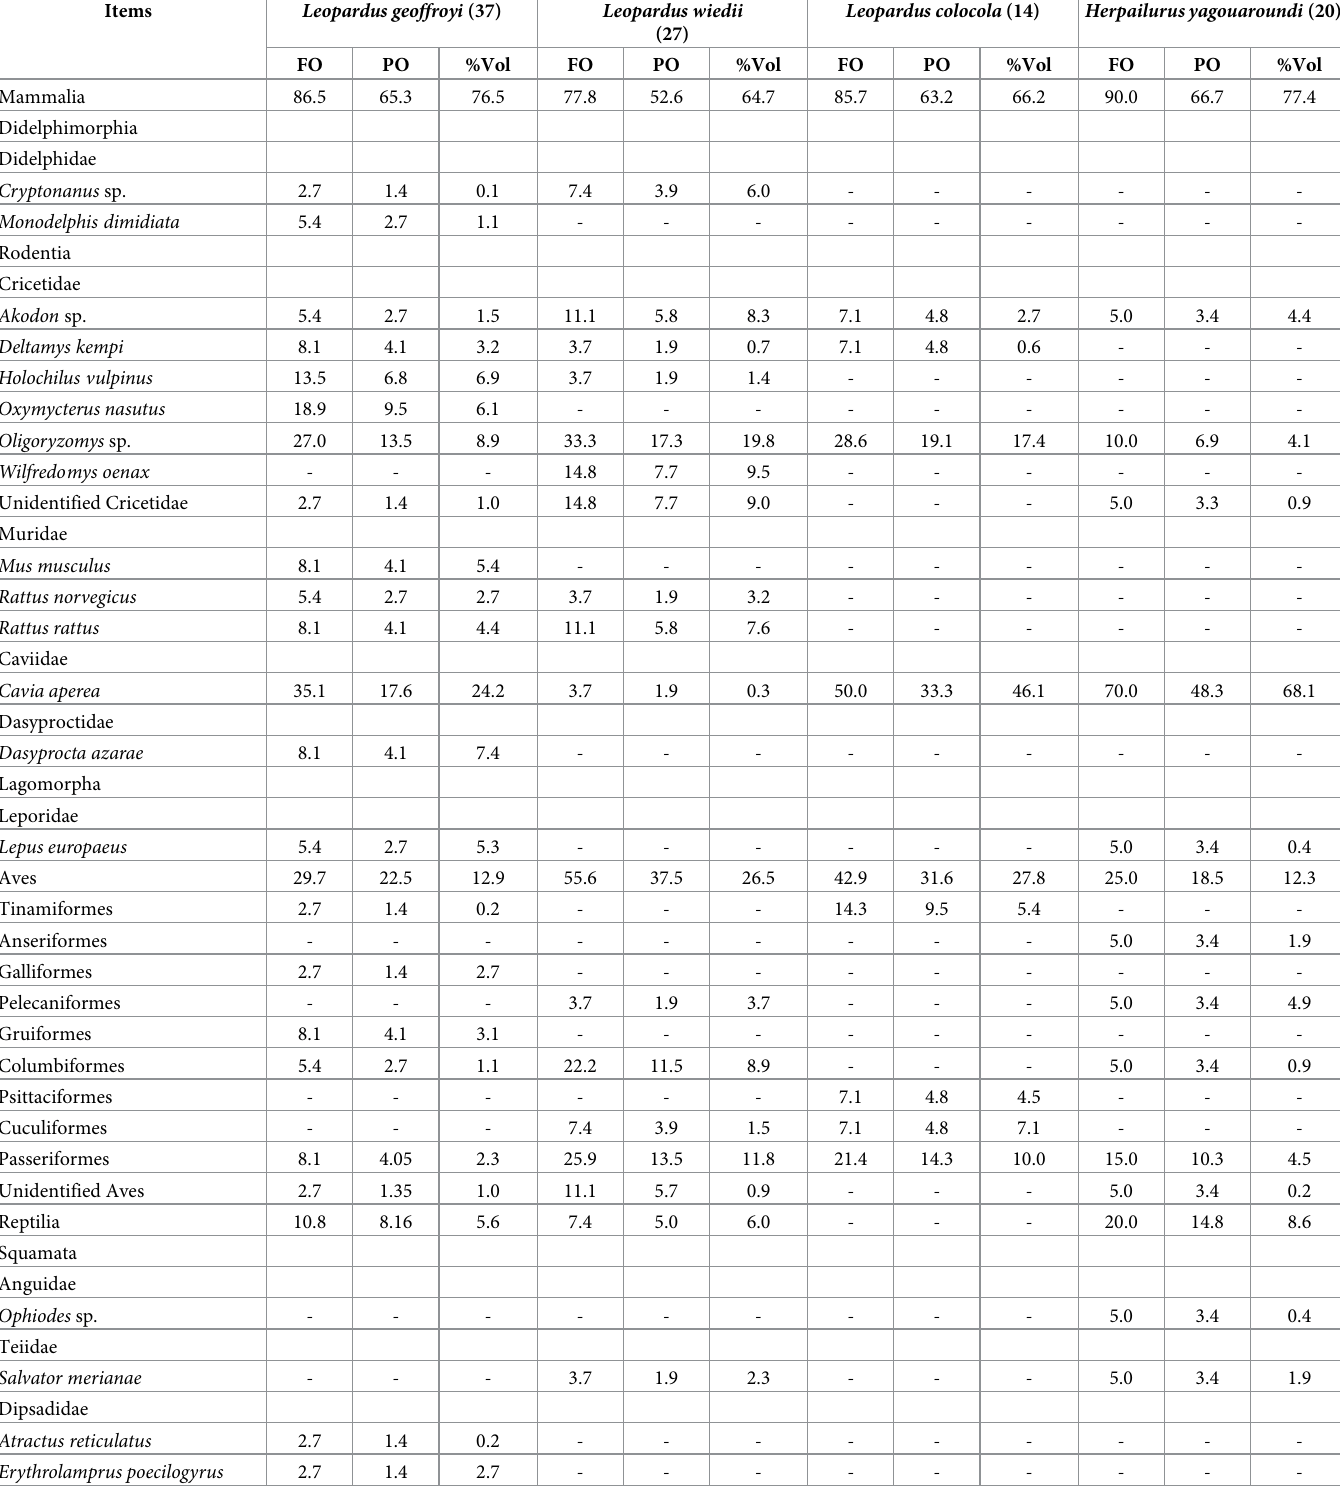
Table 1. Prey items recorded in the stomach contents of four sympatric small cat species in Brazilian Pampa, represented as Frequency of Occurrence (FO); Per- centage of Occurrence (PO) and proportional volume (%Vol.). Items